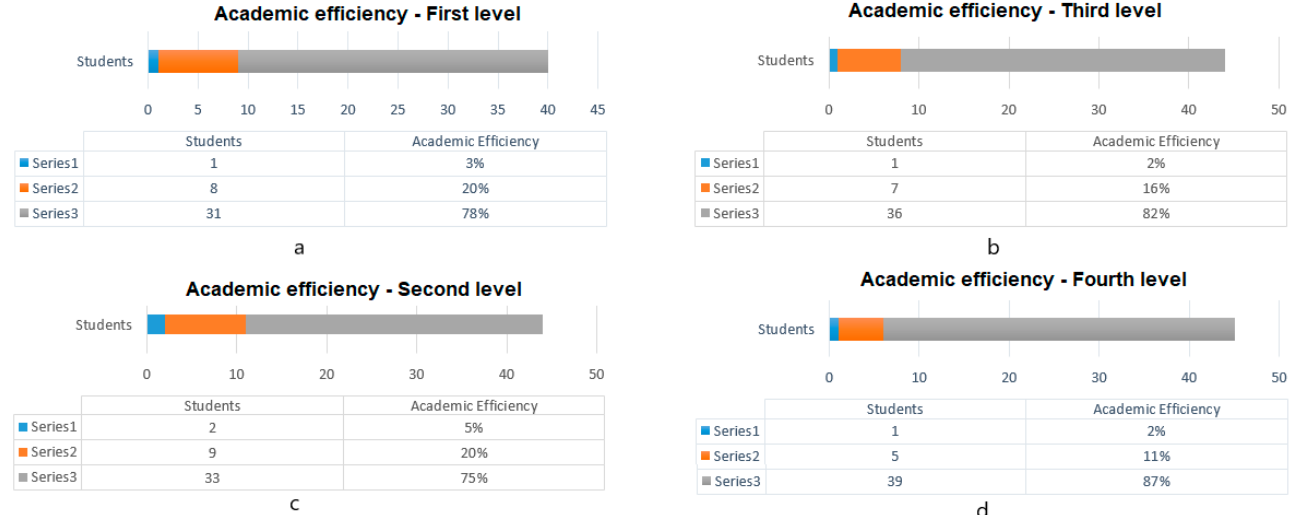
Figure 9. Analysis of the academic effectiveness (degrees) in the four initial levels of the financial career in the current education model (classes through synchronous meetings). ( a ) first level; ( b ) third level; ( c ) second level; ( d ) forth level.